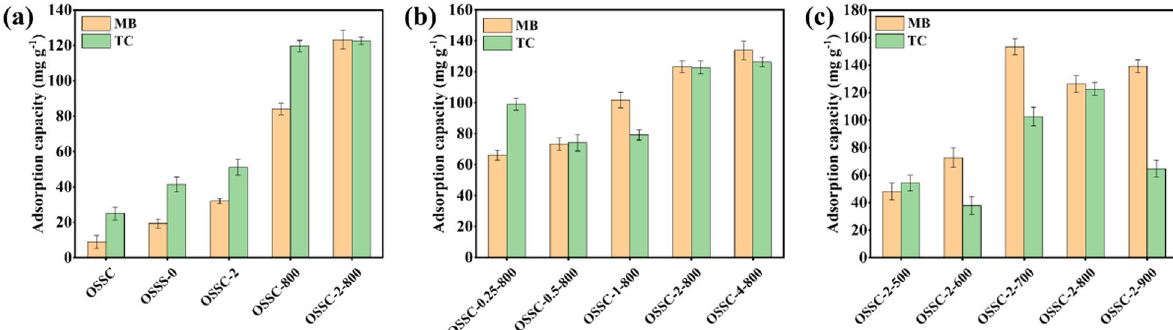
Fig. 1 Effect of preparation conditions on the adsorption capacity toward MB and TC including a different modification methods, b liquid–solid ratios of H 3 PO 4 to OSSC and c calcination